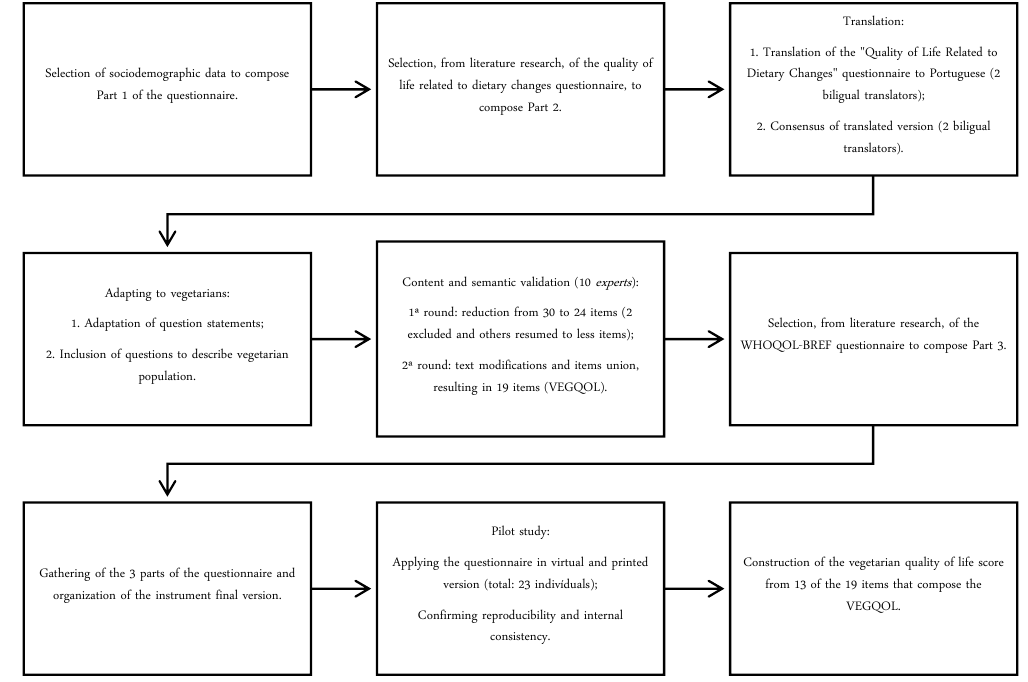
Figure 1. Flowchart of the vegetarian quality of life (QoL) questionnaire construction process.